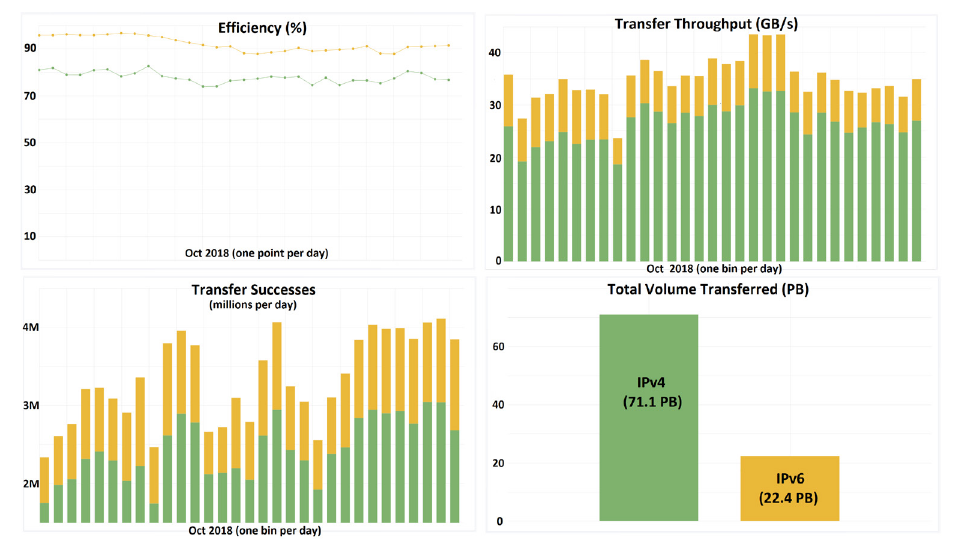
Figure 4. FTS transfer throughput for Oct 2018 and success rate according to whether IPv6 was used. IPv4 is green; IPv6 is